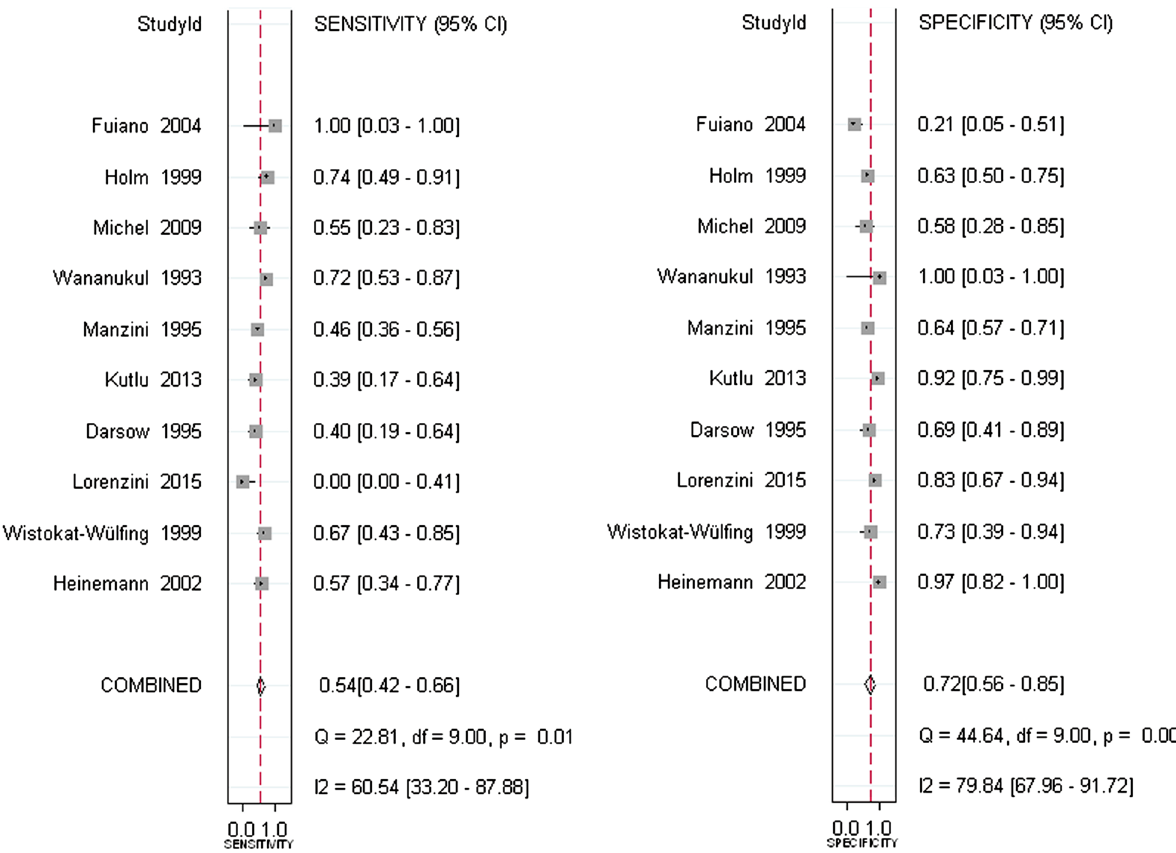
Fig. 4 Forest plot of sensitivity and specificity of APT in comparison to SPT for the diagnosis of patients with atopy dermatitis. CI confidence inter- val, ES estimates